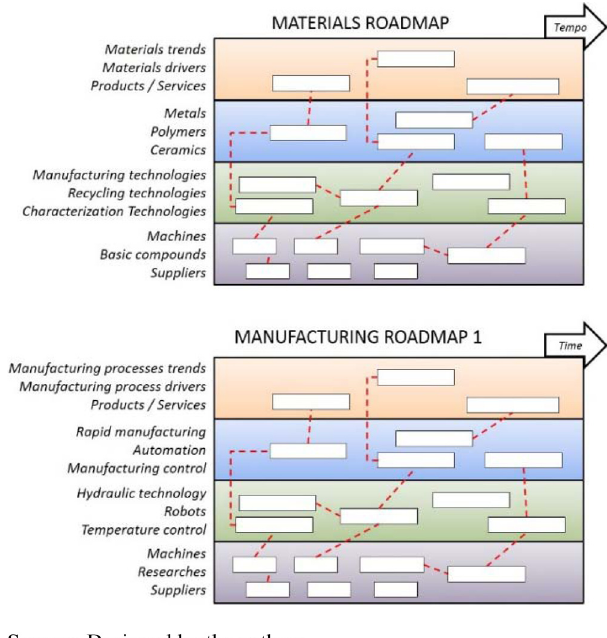
Figure 3. Example of roadmaps